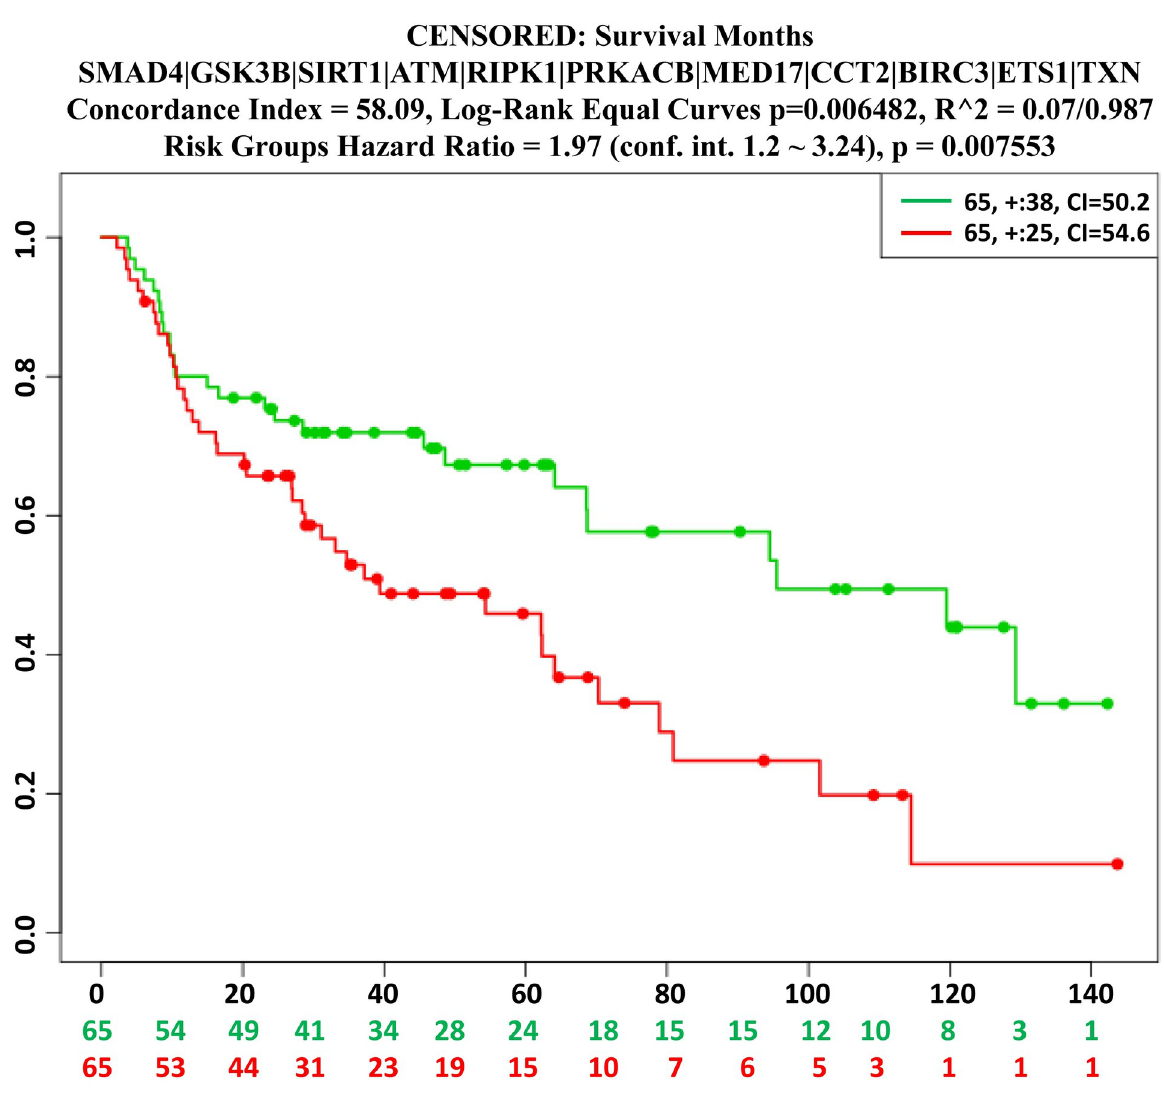
Fig 6. The multivariate survival curves of lung cancer patients based on hub-DEGs. using randomly chosen beta SARS-CoV, MERS-CoV, and SARS-CoV-2 genome sequences ( Fig 7 ). The tree was divided into four groups (Cluster-I, Cluster -II, Cluster -III, and Cluster -IV). A whole-genome comparison of SARS-CoV-2 with other coronaviruses revealed 81%, 88%, and 83% similarity to bat-coronaviruses HKU9-1 to 3, bat-SL-CoVZXC21, and MERS- CoV, respectively. Interestingly, a notable 93% sequence similarity was discovered between the bat CoV RaTG13 (Rhinolophus affinis) and SARS-CoV-2 (Lineage IV) [73]. Further finding into host selection demonstrated that the bat CoV RaTG13 is an inner joint neighbor, with MERS-CoV-Egypt being the closest relatives. The lineage II, on the other hand, revealed a long branch between SARS-CoV-2 and the close relatives bat HKU9-1, HKU9-2, and HKU9-3 with sequence similarity less than 90%, implying that these isolates may not be the direct ancestors of SARS-CoV-2. This suggests that another mammal may have delivered as an intermediate host from which the insertion was obtained. A related phenomenon was also observed in the cases of related MERS-CoV and SARS-CoV (from lineage III). Because most of SARS-outer